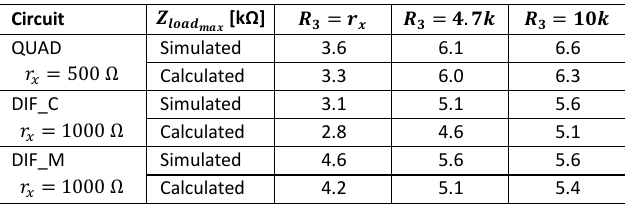
Table 1: Calculated and simulated values of Z load_max when varying R